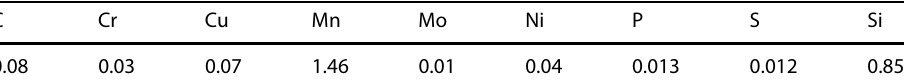
Table 3 Filler material composition typical wire composition